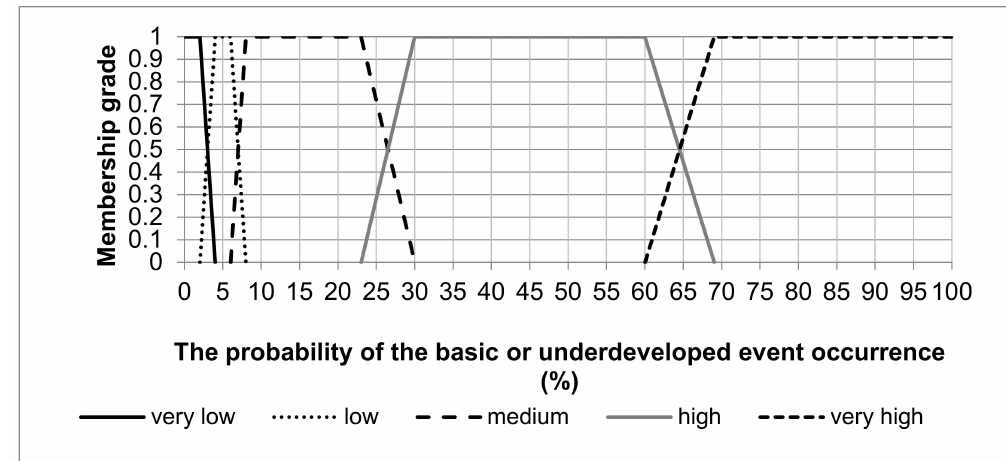
Figure 3. Membership function for the probability of the BE/UEs occurrence probability for the analyzed passive building project.